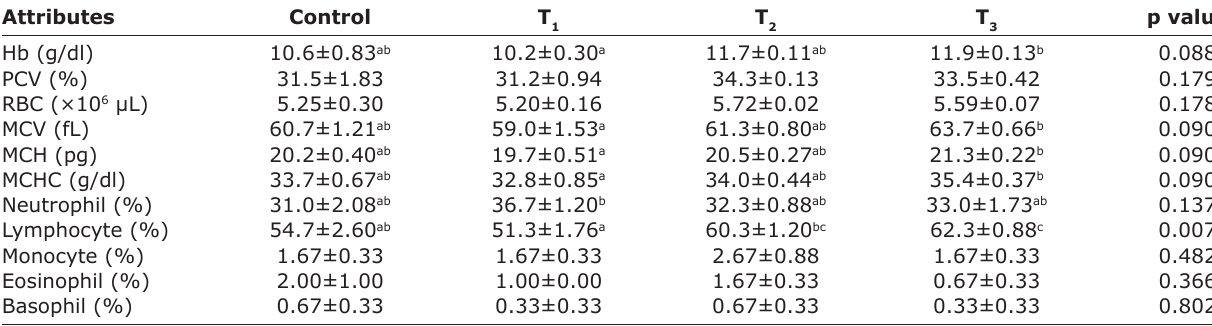
Table-2: Effect of feeding A. nilotica pod meal on whole blood parameters of goats. Attributes